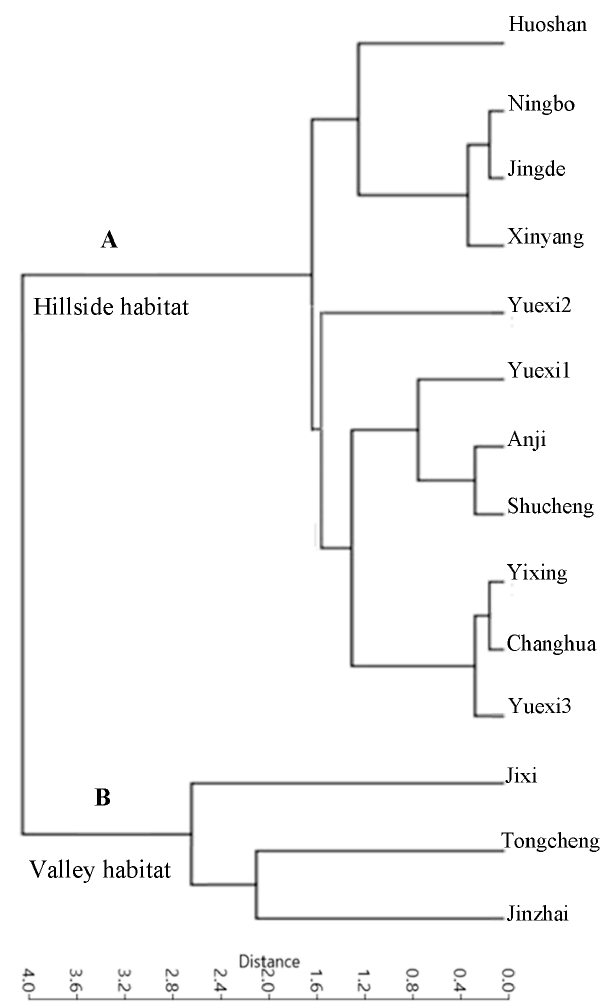
Figure 5. Unweighted pair-group method with the arithmetic means (UPGMA) analysis using variables of 15 leaf venation characteristics of P. subaequalis. (A) Hillside habitat type; (B)Valley habitat type.